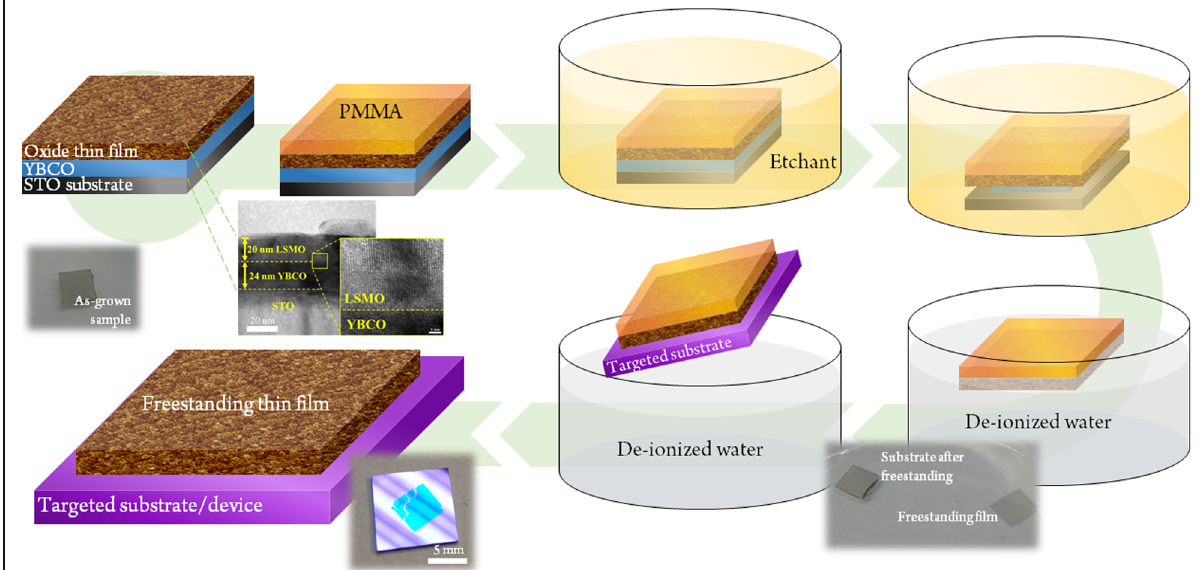
Fig. 1 Schematic of the etching process and the transfer of freestanding LSMO layers using YBCO as sacrificial